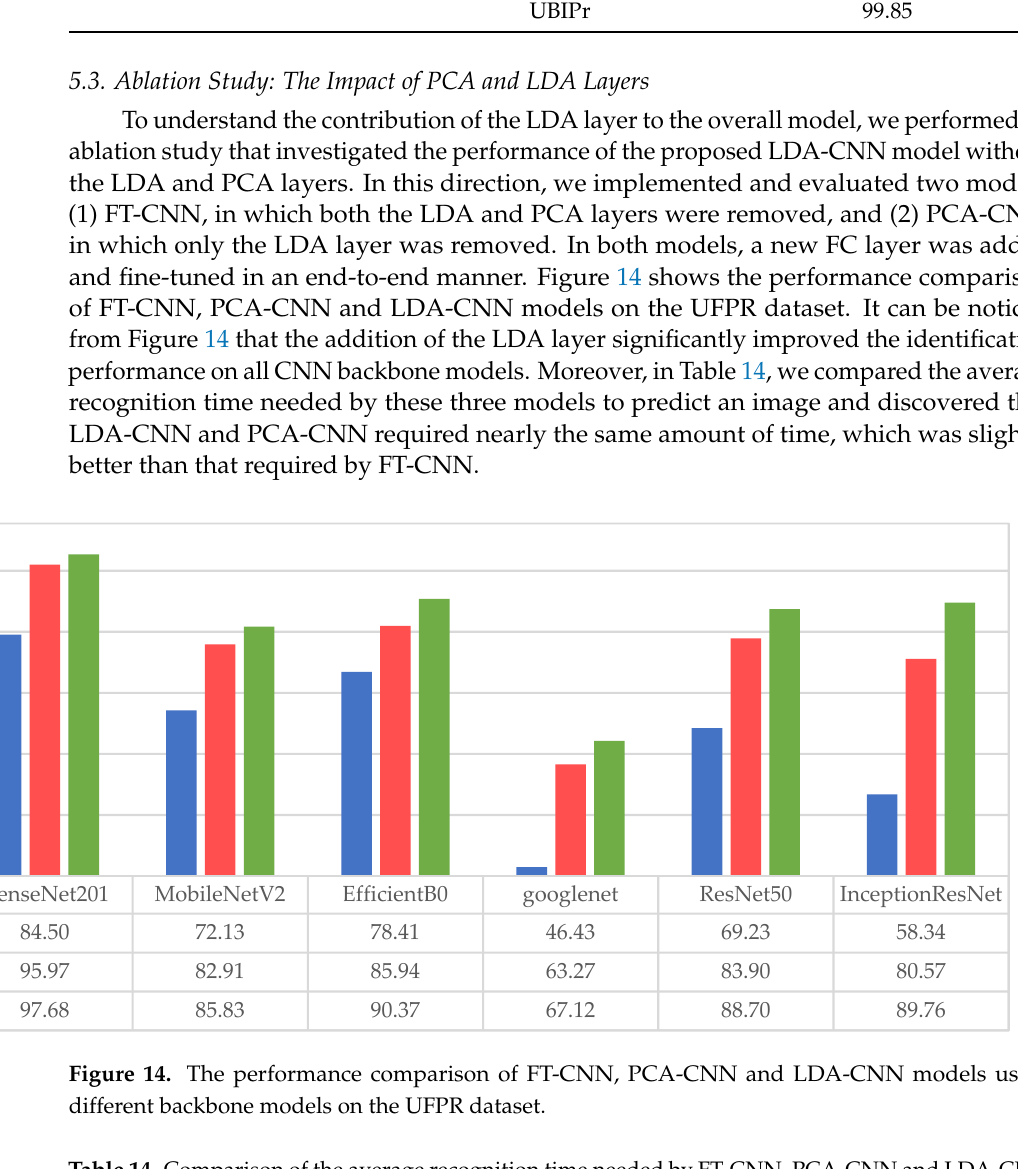
Table 13. The performance of LDA-CNN model on cross-database experiments using VISOB, UFPR and UBIPr datasets.